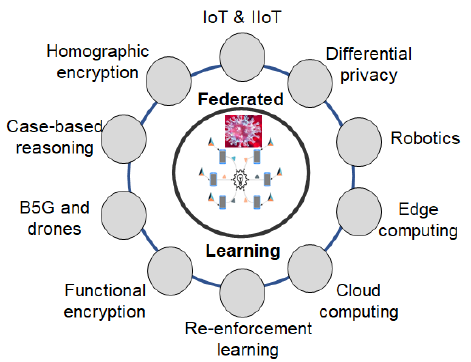
Figure 11. Recent synergies of FL with other emerging technologies in the context of